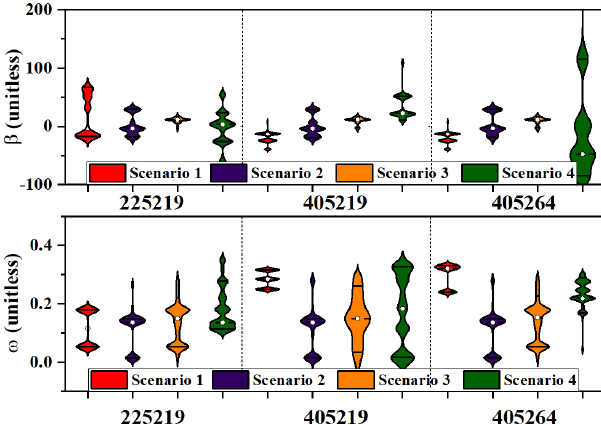
Figure 9. Posterior distributions of the regression parameters ( β and ω ) for the production storage capacity ( θ 1 ) for the four model sce- narios in each catchment when calibrated in the dry years and ver- ified in the wet years. The solid horizontal lines within the violin plots denote the 25th and 75th percentiles of the posterior distribu- tion, while the white dots denote median